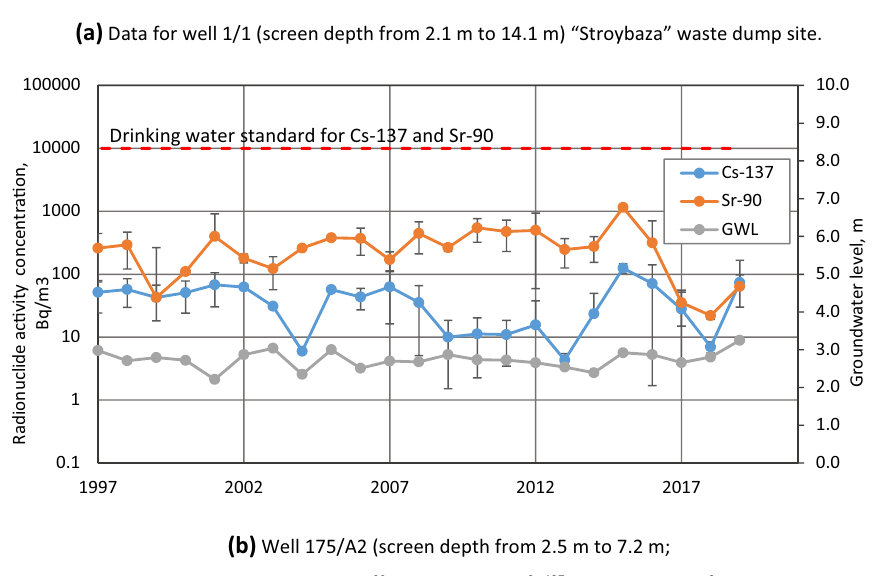
Figure 4. Groundwater monitoring data for ( a ) well 1/1 in the “Stroybaza” waste dump site and ( b ) in an area of high surface soil contamination in the 10-km zone of the ChNPP. Vertical bars represent standard deviation of data during a